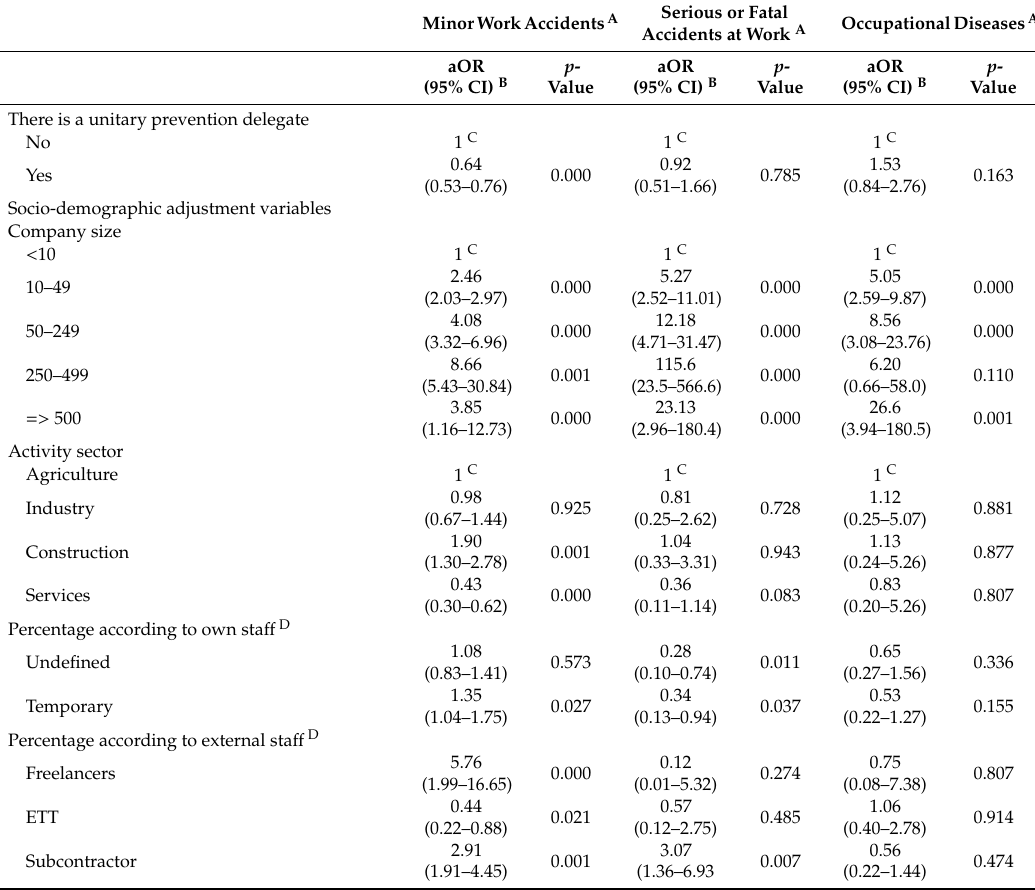
Table 5. Adjusted logistical regressions between the presence of unitary prevention delegates and damage to occupational